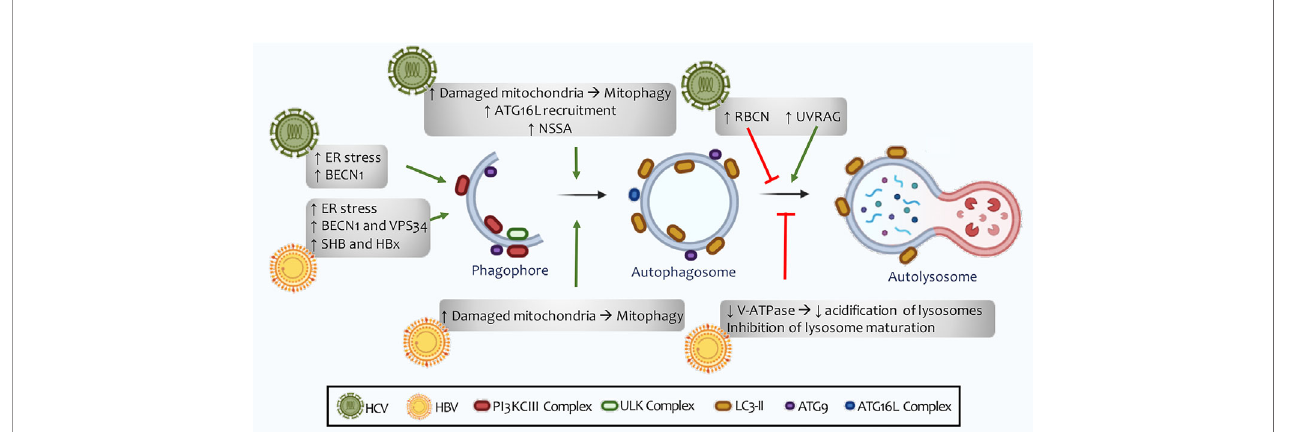
FIGURE 7 | HCV and HBV regulation of autophagy. The autophagic machinery is necessary for incoming viral RNA translation, but it becomes expendable once the viral replication process begins. An increase in the number of autophagosomes does not correlate with an increase in the rate of lysosomal degradation. HCV has been shown to induce the expression of Rubicon, thus inhibiting the maturation of autophagosomes. For its part, HBC reduces the acidi fi cation of lysosomes and autolysosomes through the inhibition of V-ATPase (H + type vacuolar enzyme). However, in vitro studies show good fusion of autophagosomes with lysosomes, as well as successful autophagic fl ow, indicating that these viruses are able to induce selective autophagy in some cellular organelles, such as the mitochondria and lipid deposits in